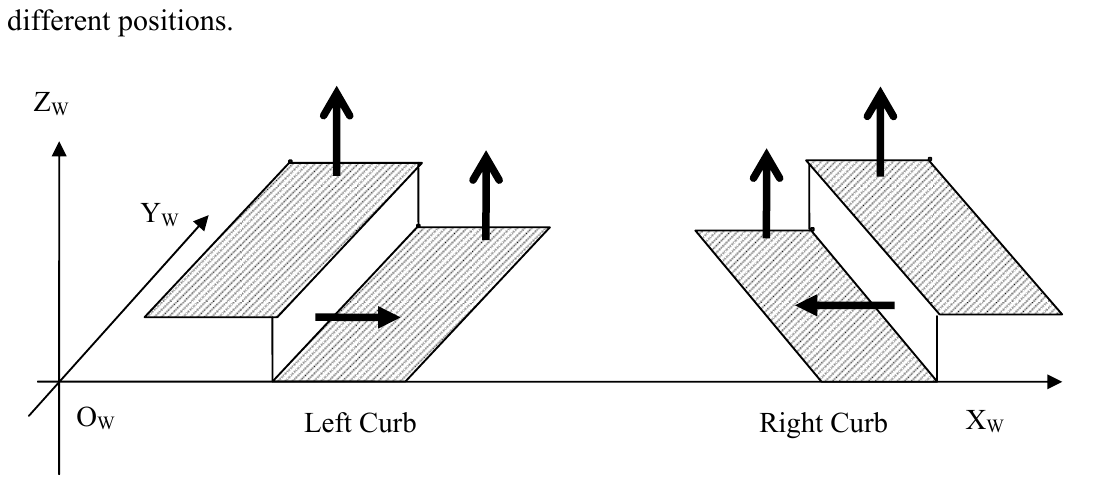
Figure 1. Geometric model of curbs. The short arrows indicate the surface normal directions in different